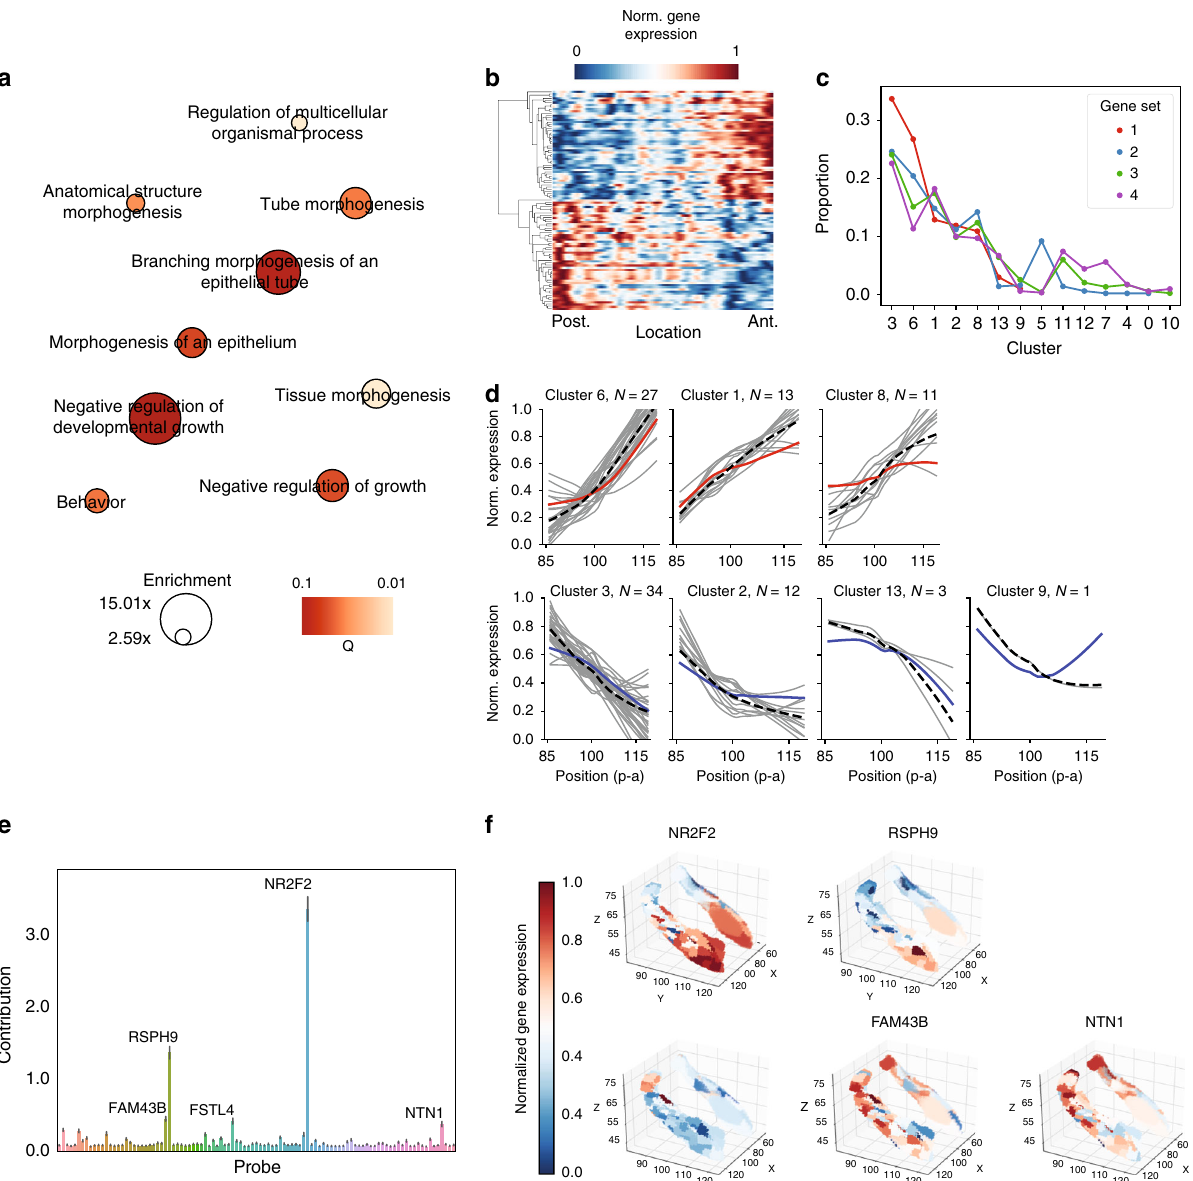
Fig. 2 Candidate genes associated with the longitudinal axis of the human hippocampus. a Enriched Gene Ontology terms ( Q < 0.1) associated with Gene Set 1. Circle size indicates enrichment, whereas color indicates Q value (lighter = lower Q value). b Matrix showing gene expression for probes in Gene Set 1 ( y -axis) across each hippocampal sample, ordered most posterior to most anterior ( x -axis). Values were smoothed with a 3 mm gaussian kernel across the x-dimension only and then clustered so that anterior – posterior patterns can be clearly visualized. c Relative proportion of features belonging to each expression pattern cluster, for each Gene Set. d Each subpanel represents an expression pattern cluster, and the subpanel heading includes the number of probes from Set 1 assigned to that cluster. For each cluster, the posterior-anterior normalized expression pattern is shown for each Gene Set 1 feature belonging to that cluster (gray), the mean of Set 1 features belonging to that cluster (black dashed), and the mean of features across all sets belonging to that cluster (colored). e Average absolute local feature importances (and by extension, model contribution) of probes in Gene Set 1 measured using a Random Forest-based feature explainer across all samples. Error bars = standard error of mean. f Surface rendering of the expression patterns of each of the fi ve genes identi fi ed as locally important features to predicting position along the longitudinal